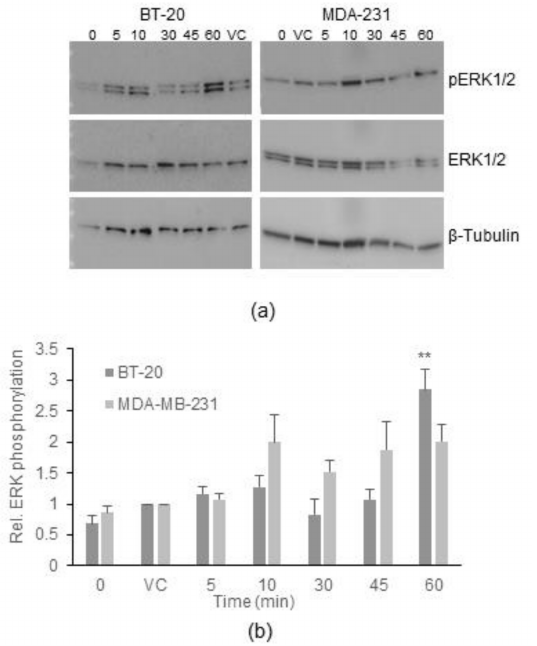
Figure 4. KP-10 only activates ERK1/2 in BT-20, but not MDA-MB-231 cells. BT-20 and MDA-MB-231 cells were serum deprived for 4 h before exposure to 100 nM KP-10 for 5, 10, 30, 45, or 60 min. Un- stimulated (0 min) and vehicle treated (VC) controls were included. ( a ) A representative Western blot image depicting phosphorylated ERK1/2, total ERK1/2 and β -tubulin expression in unstimulated (0 min), vehicle control (VC), 5 min KP-10, (5), 10 min KP-10 (10), 30 min KP-10 (30), 45 min KP-10 (45), and 60 min KP-10 (60) samples. ( b ) Quantification of three independent repeats (mean ± SEM) of relative ERK1/2 phosphorylation in BT-20 (dark grey bar) and MDA-MB-231 (light grey bar) cells. ** p ≤ 0.01 (one-way ANOVA followed by Dunnett’s post-hoc test) to determine significant increases in ERK1/2 phosphorylation compared to the VC for each cell